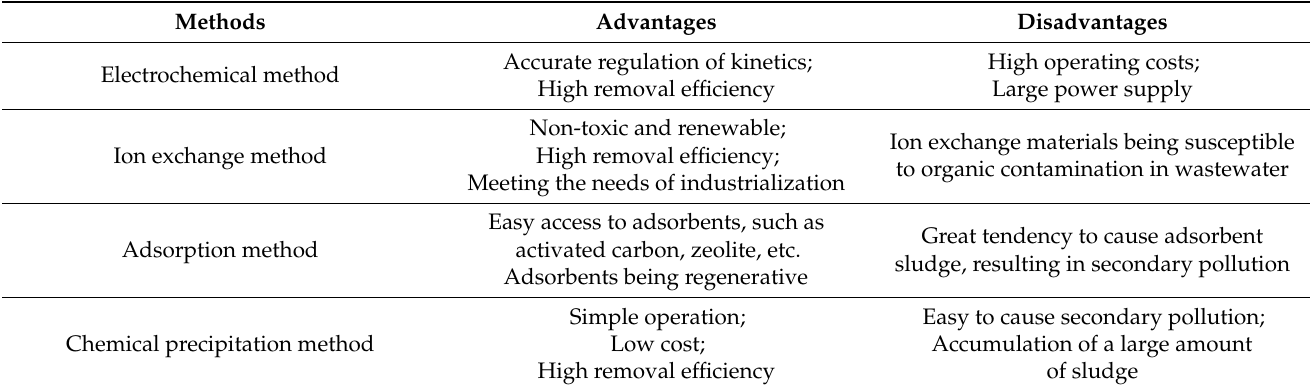
Table 1. Advantages and disadvantages of different physicochemical methods for Mn